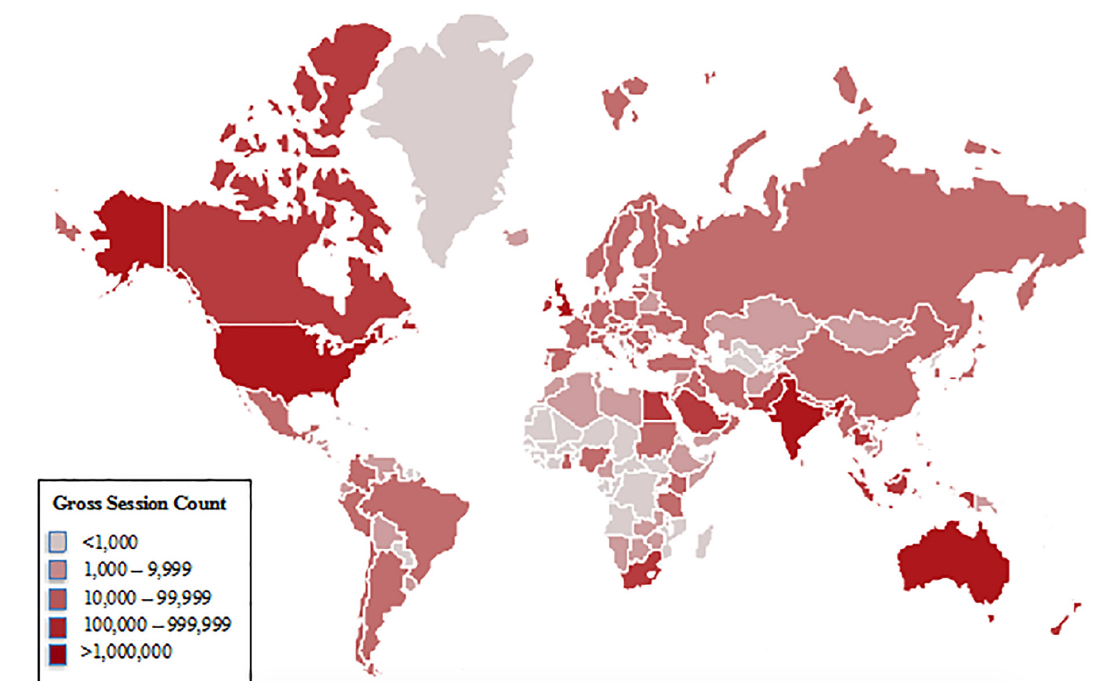
Figure 2. Global FOAM distribution- Gross annual session counts by country, 2016. FOAM , Free Open Access Medical education.